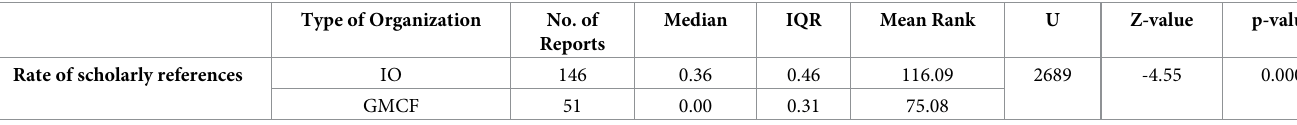
Table 4. Mann-Whitney U test of rate of scholarly references across IOs and GMCFs. Type of